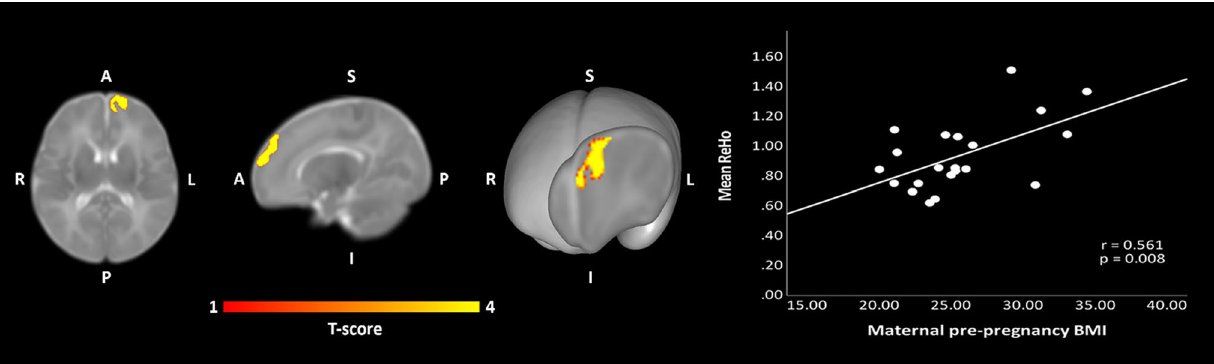
Figure 1. Regions where ReHo significantly correlated with maternal pre-pregnancy BMI ( p < 0.005 threshold; p < 0.004 FWE-corrected) highlighted left SFG within the naturally sleeping neonate (N = 21). Color bar represents T-scores. Images are displayed in radiological convention on the UNC template in axial, sagittal and oblique slices. Oblique section was created with Mango surface builder. Abbreviations: ReHo = regional homogeneity; SFG = superior frontal gyrus; A = Anterior, P = Posterior, R = Right, L = Left, S = Superior, I =